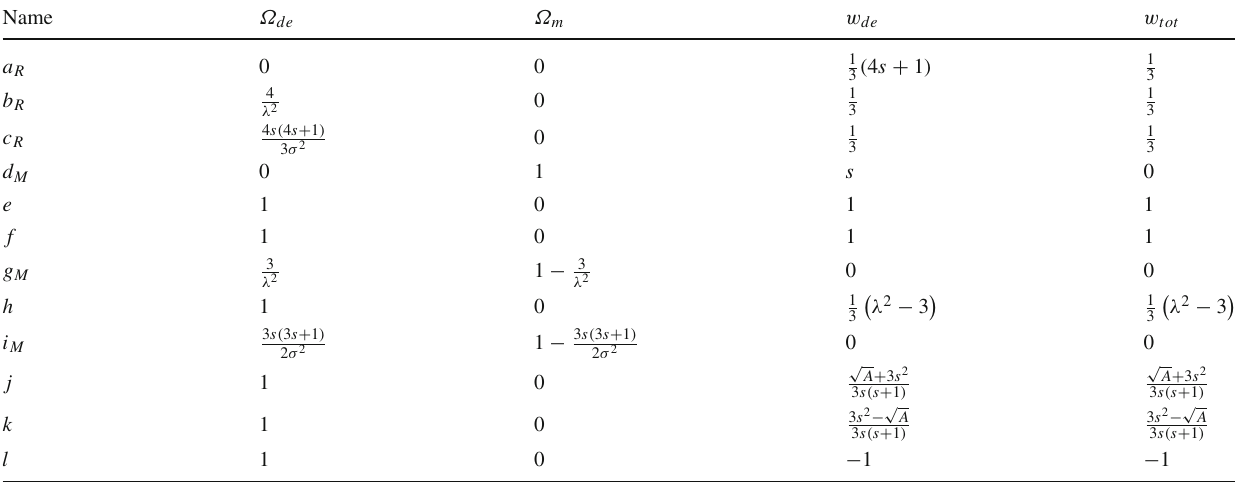
Table 2 Cosmological parameters for the critical points in Table 1. We define A = 9 s 2 ( 2 s + 1 ) 2 − 6 s ( s + 1 )σ 2 . The fractional energy density of the radiation fluid is calculated through Ω r = (cid:2) 2 = 1 − Ω m − Ω